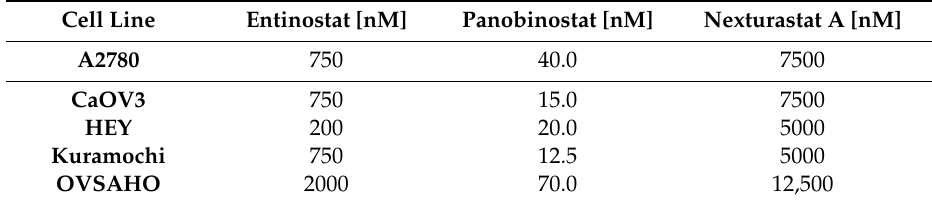
Table 4. HDACi concentrations used for combination treatment.